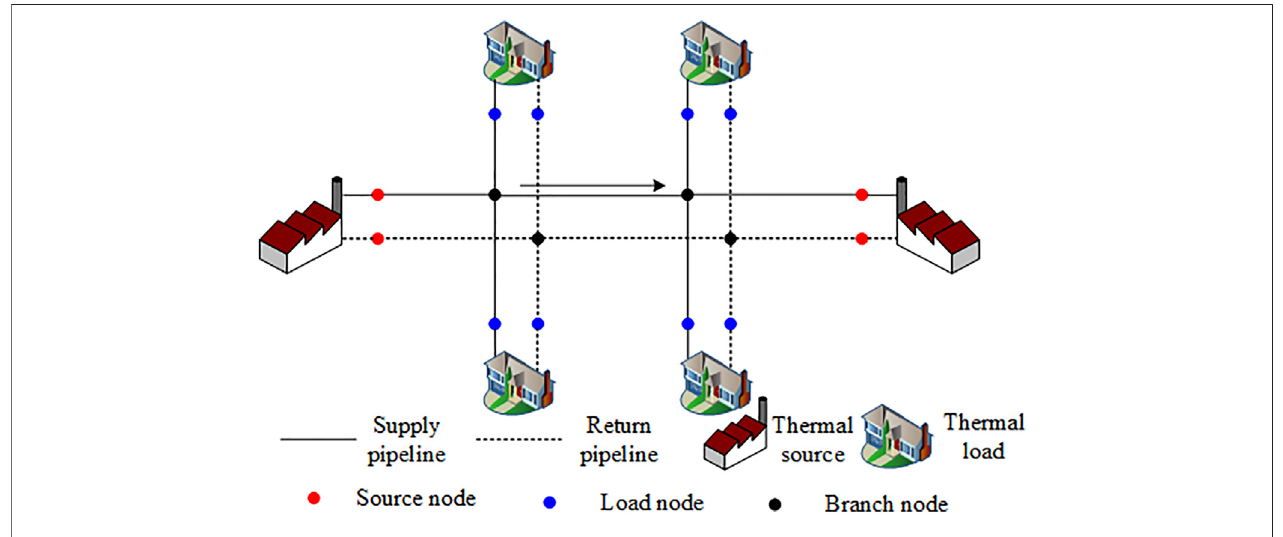
FIGURE 1 | Structure of heating